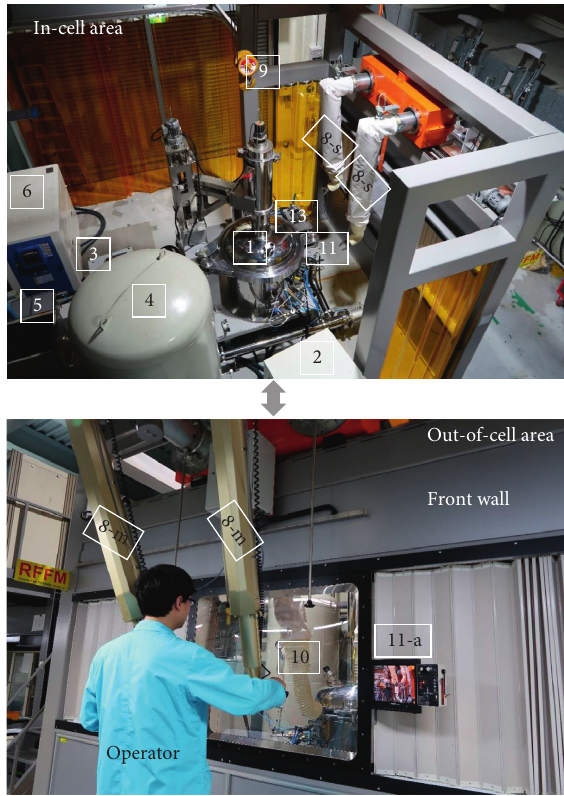
Figure 2: RFFM constructed at KAERI.